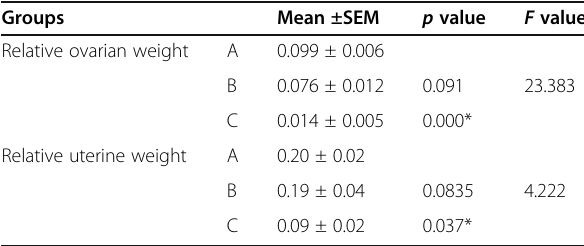
Table 2 The effect of MEPO on the relative organ weight of adult female Wistar rats Groups Mean ±SEM p value F value Relative ovarian